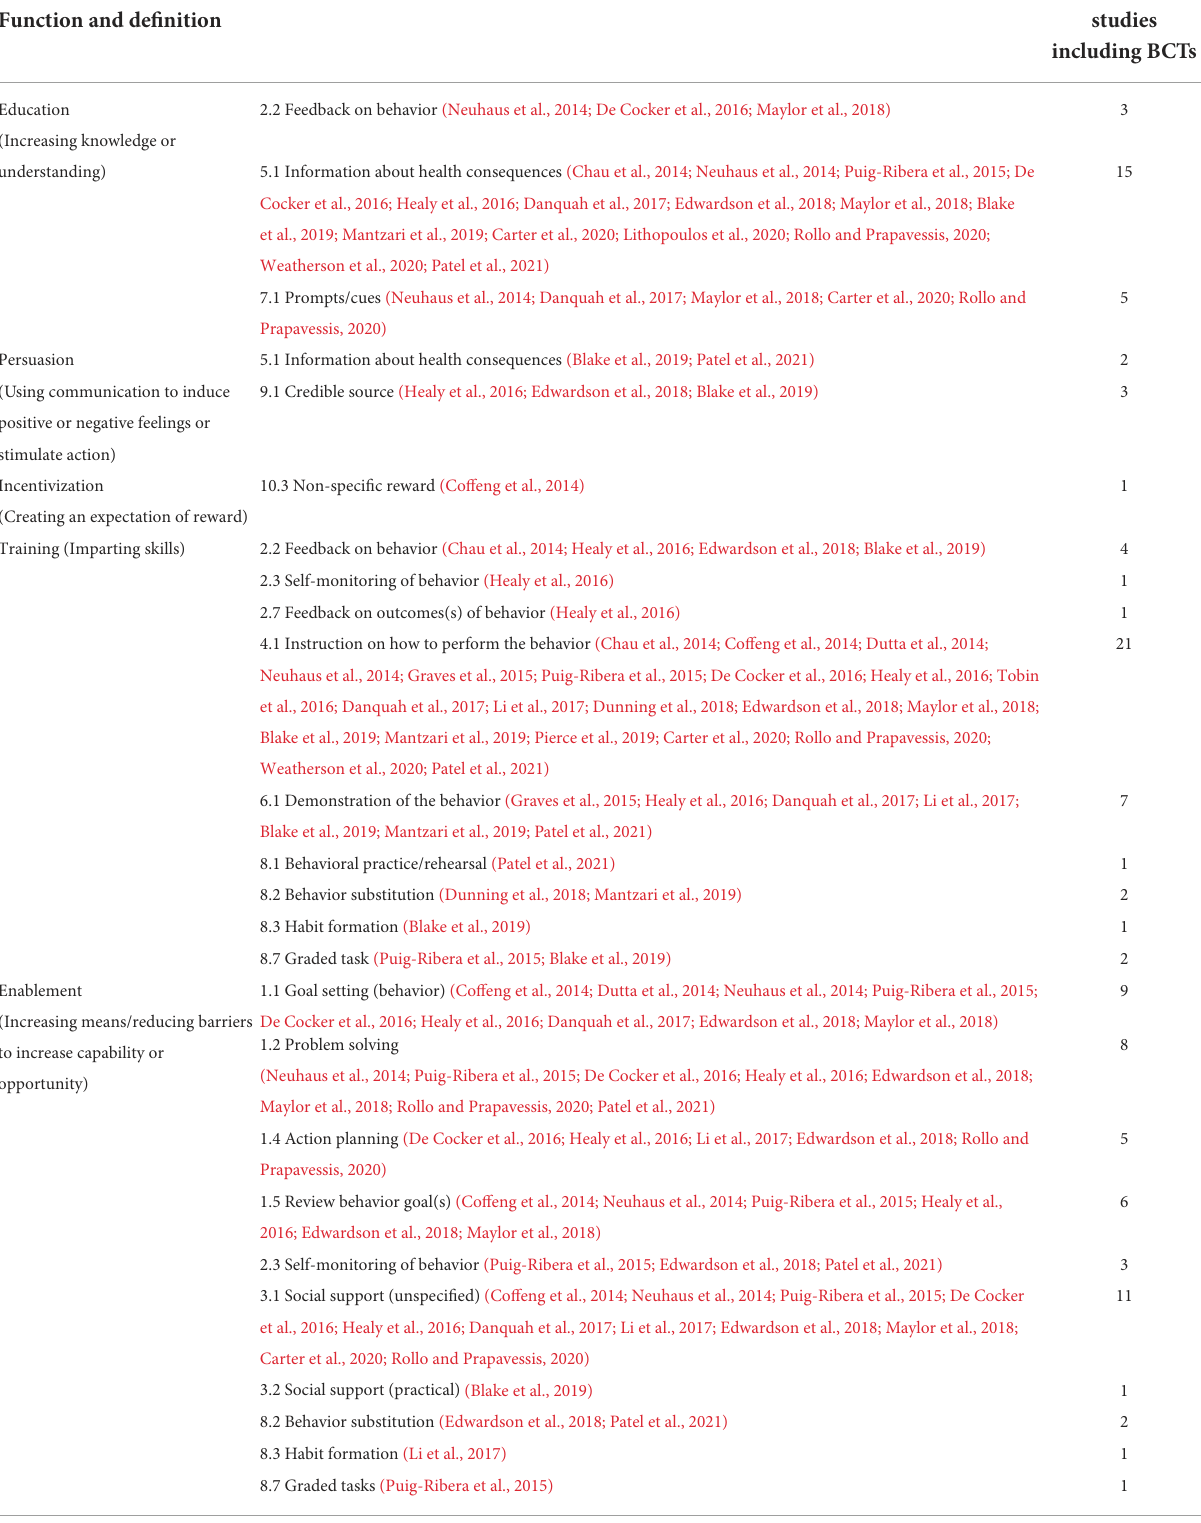
TABLE 4 The BCW intervention functions and BCTs evident in the included studies. BCW Intervention BCT and Function and definition